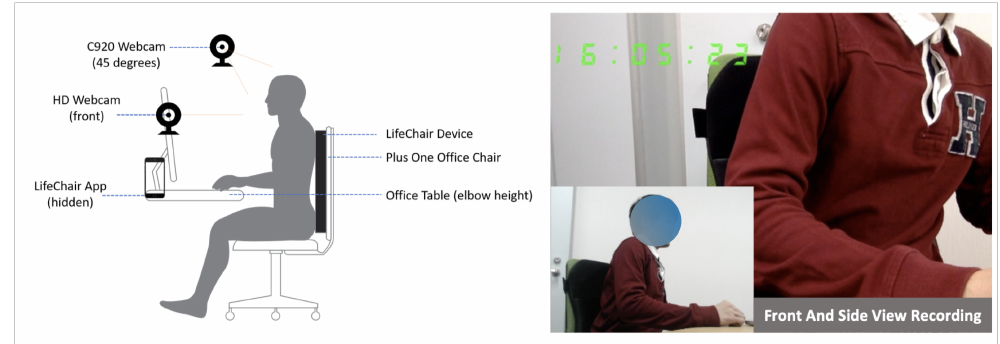
Figure 4. Overview of the experimental setup of sitting posture and stretch pose data